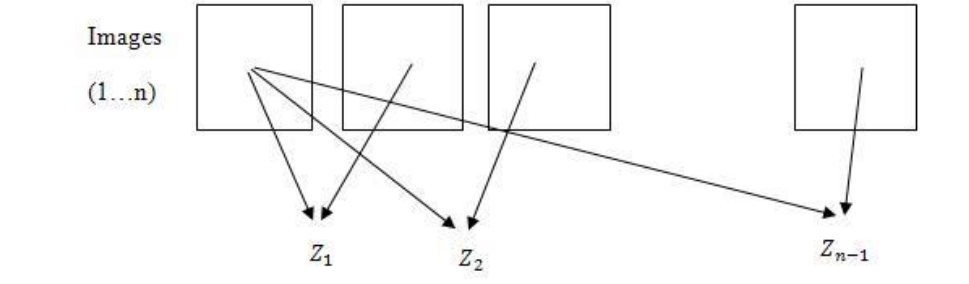
Figure 1. Different views arrangements and corresponding depth values.